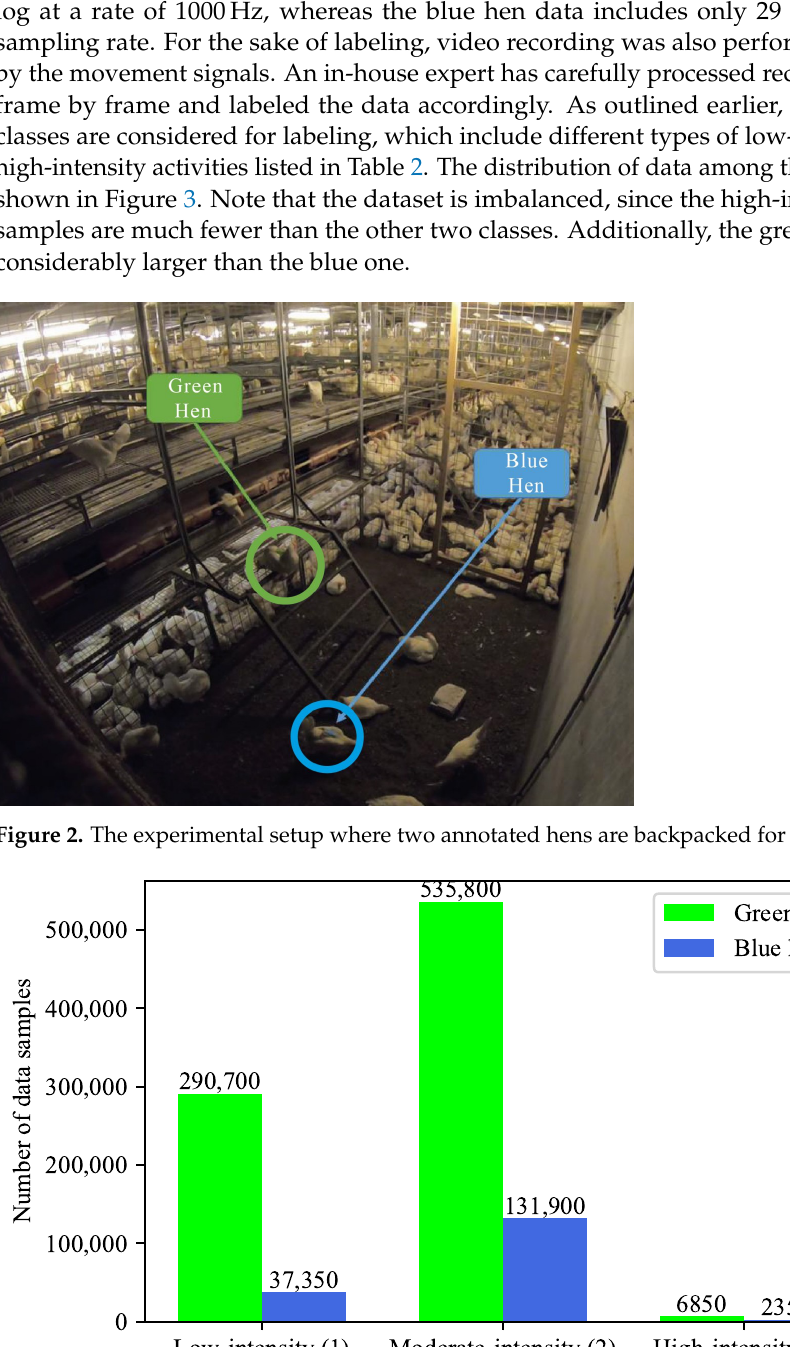
/RZLQWHQVLW\ 0RGHUDWHLQWHQVLW\ Figure 3. Overview of green and blue hen